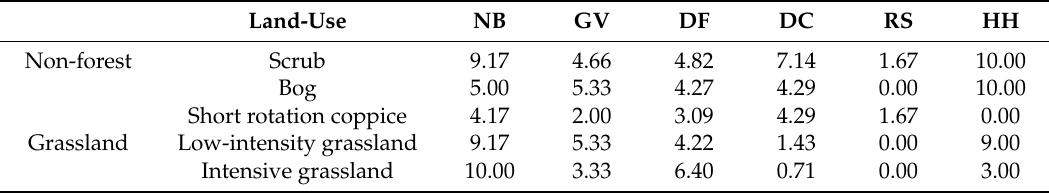
Table A9. Agricultural (grassland and tillage) and non-forest biodiversity scores post scaling (including the deer forage